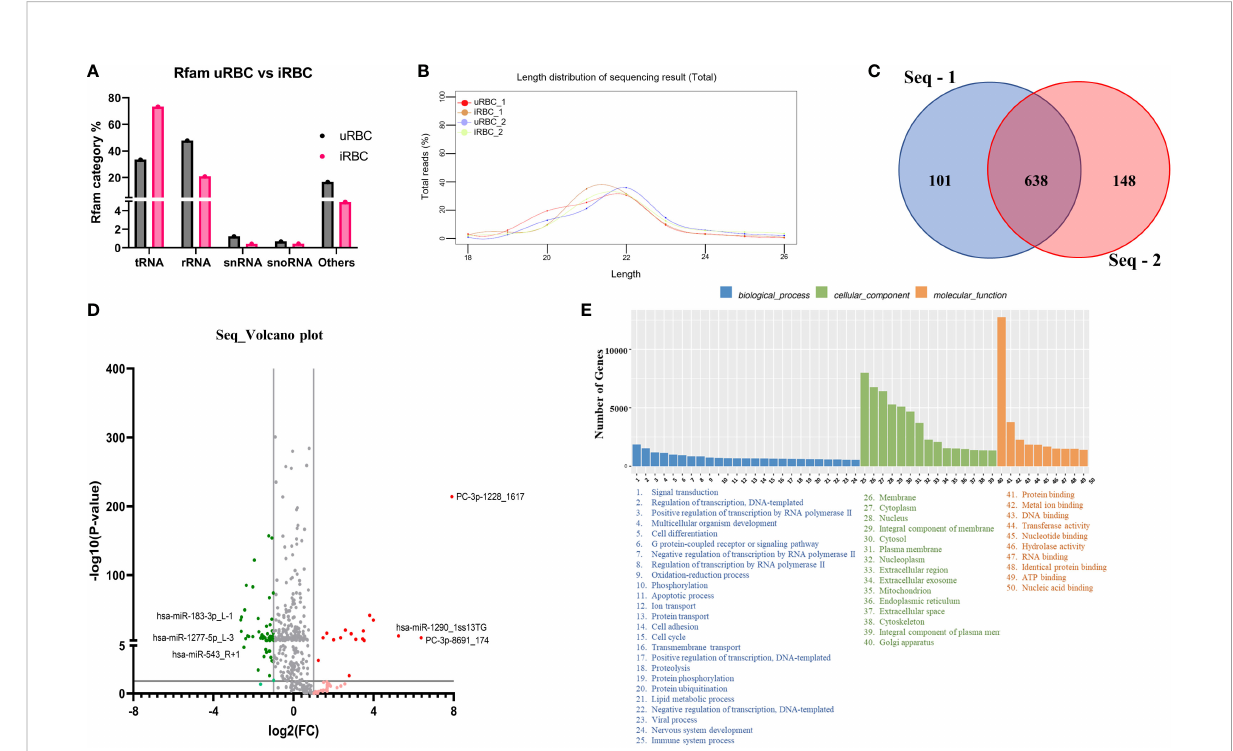
FIGURE 6 MicroRNA (miRNA) Illumina sequencing results in identi fi cation of differential miRNA expression in extracellular vesicles (EVs) from uninfected RBCs (uRBCs) and B. divergens – infected RBCs (iRBCs). (A) Percentage of different non-coding RNAs in EVs from uRBCs (black bars) and iRBCs (pink). “ Others ” refers to non-coding RNAs that did not match any known sequence in the Rfam 14.8 database. (B) Length distribution of small RNA used in the study was found to be between 20 and 24 nt. (C) Venn diagram depicting differences and similarities between the biological replicates used in the study shows signi fi cant overlap between the replicates. (D) Volcano plot showing differential expression of miRNAs. FC on x-axis refers to fold change in B. divergens – infected derived EVs compared with uRBCs and FC of more than/less than 2 were considered signi fi cant (shown by two vertical lines). Y-axis shows the statistical signi fi cance, and the cutoff chosen was p < 0.005, as shown by the black horizontal line. Gray dots were miRNAs that were non-signi fi cant in terms of p value and FC. Light red and light green dots represent miRNAs that were upregulated and downregulated, respectively, with an FC of more than/less than 2 but did not pass the p-value test. Dark red and dark green dots represent miRNAs with FC more than or less than 2, respectively, and signi fi cant p-values. The top three miRNAs in each set were identi fi ed. (E) Biological pathways (blue), cellular localization (green), and molecular function (orange) related to the miRNAs identi fi ed in the analysis and its related number of genes were plotted as bar graphs. As shown, several pathways are hypothesized to be altered by these